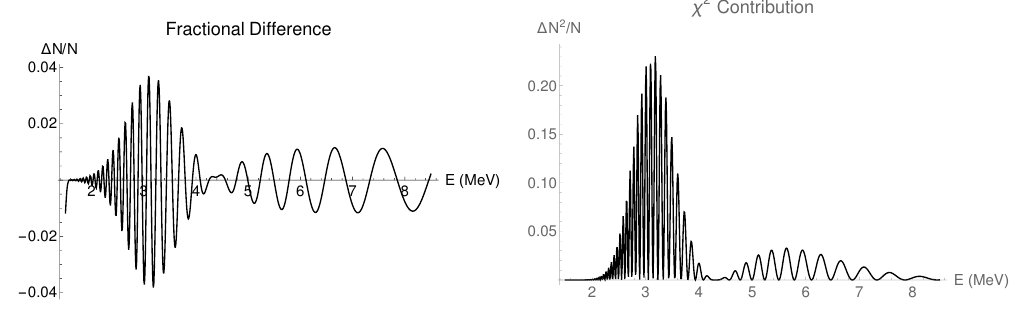
Figure 2 . Di(cid:11)erence between the spectra from the right panel of (cid:12)gure 1. Left panel: fractional di(cid:11)erence. Right panel: (cid:31) 2 contribution (i.e. (cid:1) N 2 =N